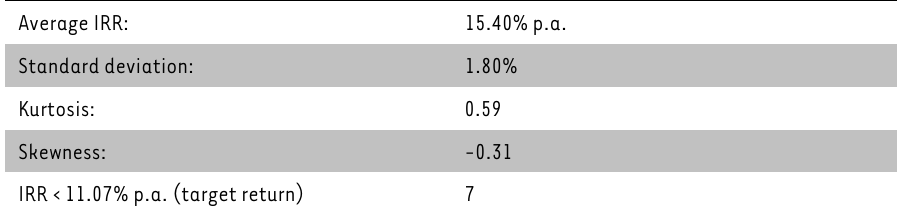
TABLE 12 indicates the volatility of the IRRs of Set E investments in the Alsi, excluding the five data points where funds were depleted. TABLE 12: Volatility of the IRRs of the investments of Set E Average IRR: